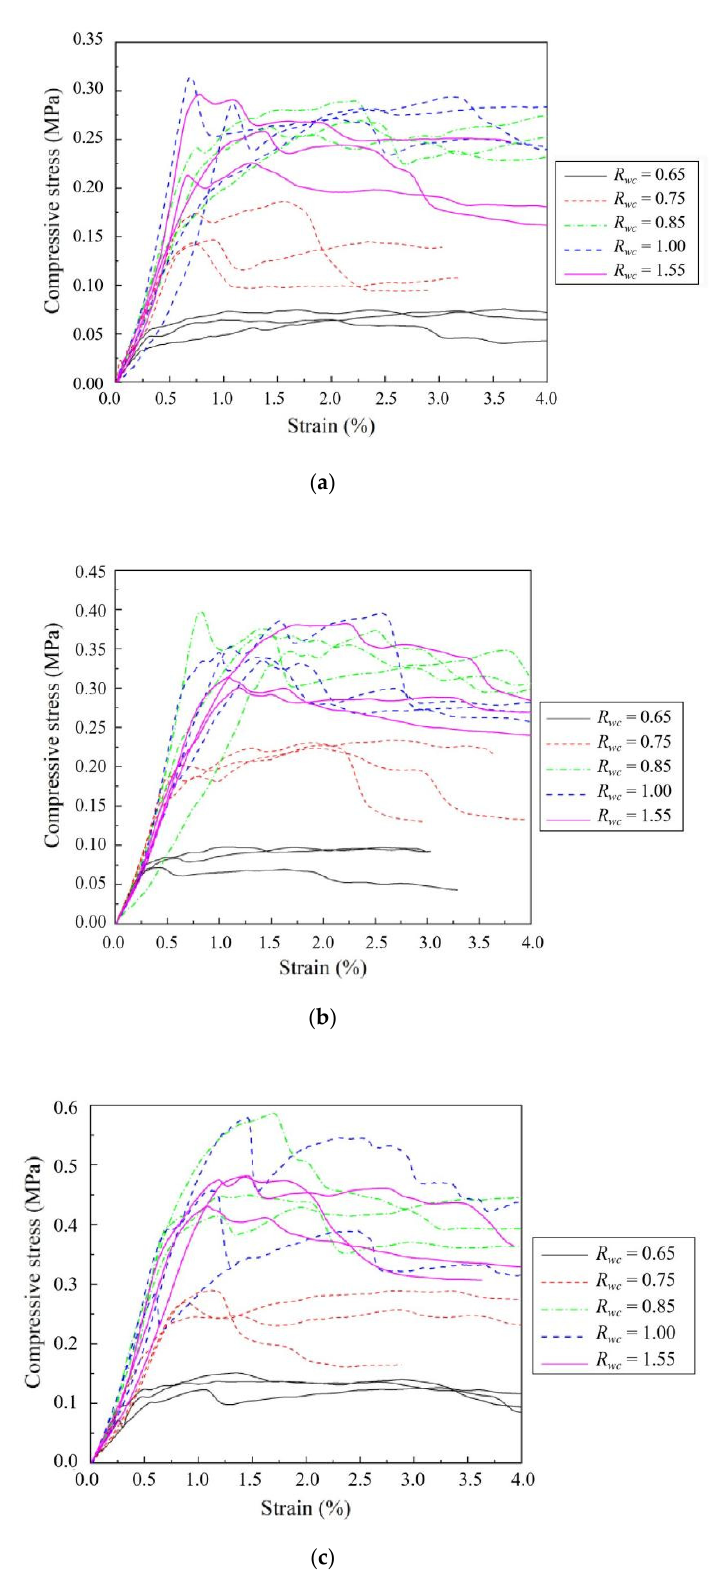
Figure 5. Stress-strain curves of foam concrete at the ages of ( a ) 3, ( b ) 7 and ( c ) 28 days with the R sc of 5 at various R wc .